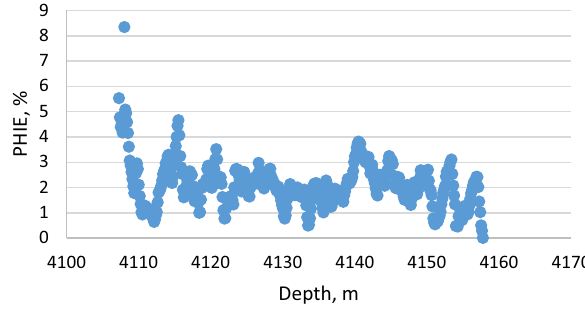
Fig. 9 Effective porosity of the Lockhart Limestone of Meyal-05P,